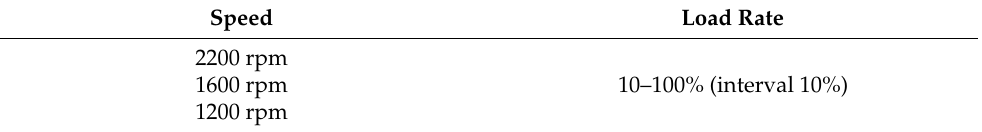
Table 3. Test conditions of the